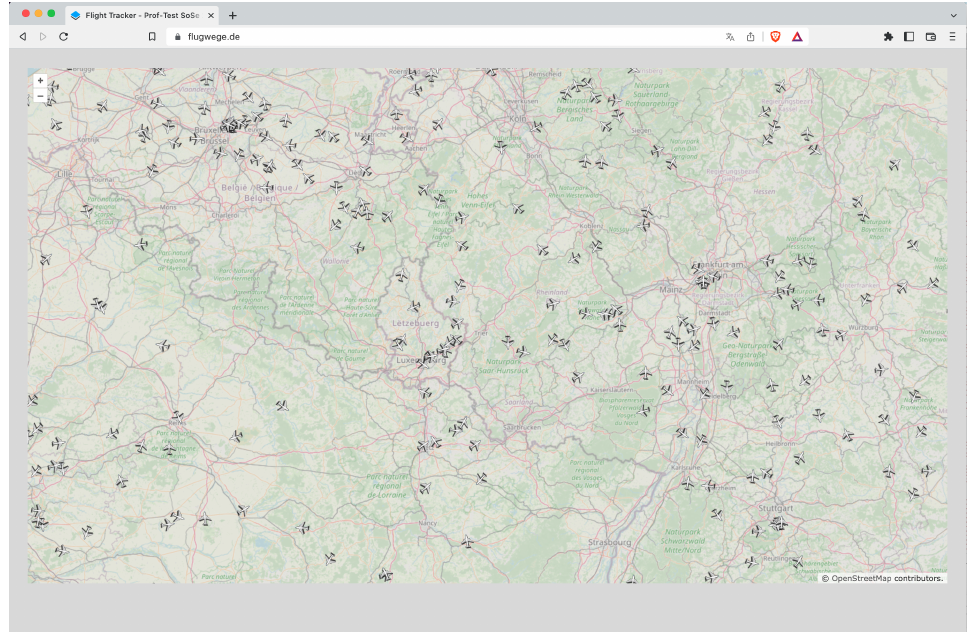
Figure 4. Flight-tracking web application.